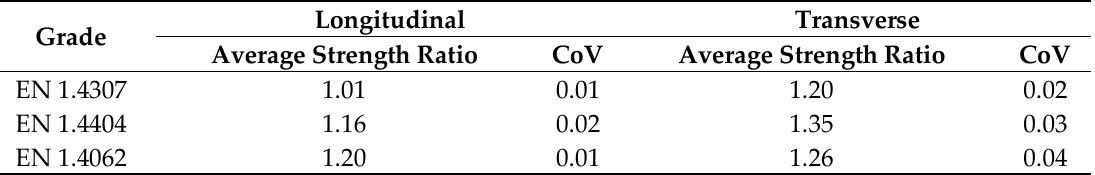
Table 4. Average strength ratio for each grade and